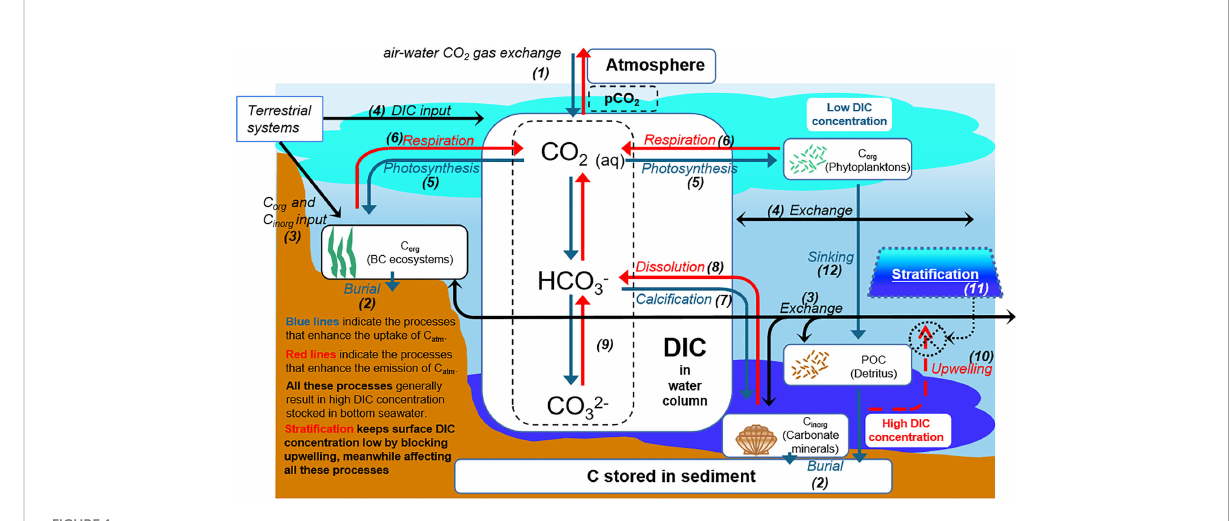
FIGURE 1 Schematic diagram of CO 2 dynamics in shallow coastal